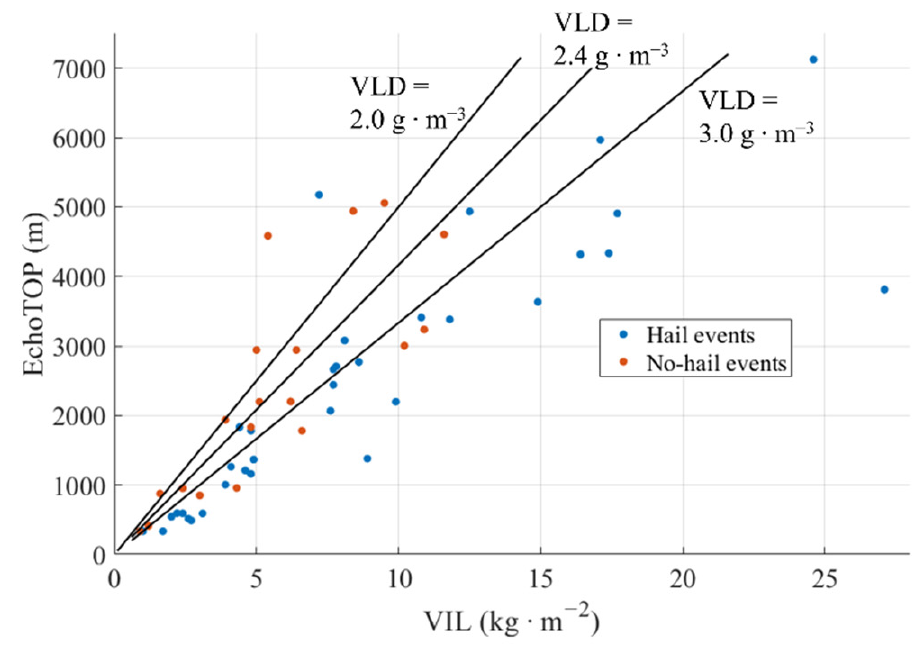
Figure 5. Scatter diagram of VIL (kg · m − 2 ) versus EchoTOP (m) for the 53 thunderstorm events analyzed in [20]. The hail-producing and the non-hail-producing convective events are marked as filled-in blue and red circles, respectively. Values of VLD (g · m − 3 ) are shown as black solid lines, labeled 2.0, 2.4 and 3.0.